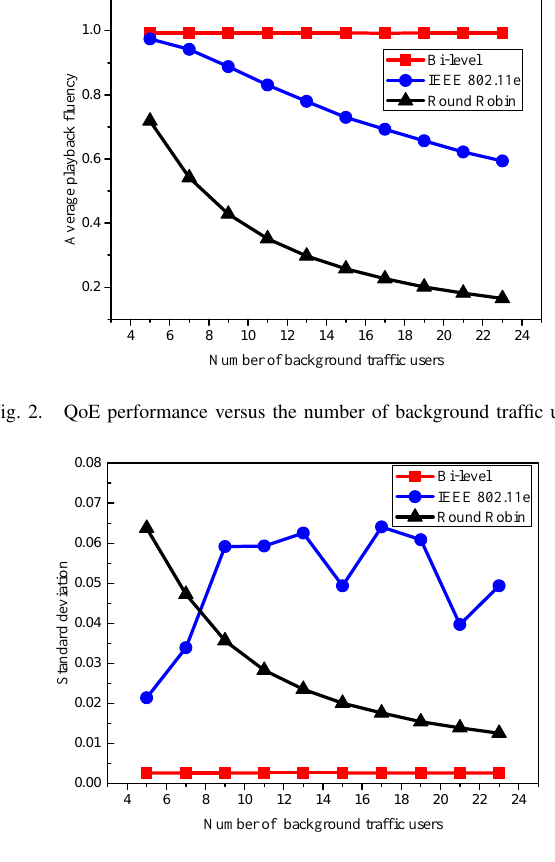
Fig. 3. Fairness versus the number of background traffic